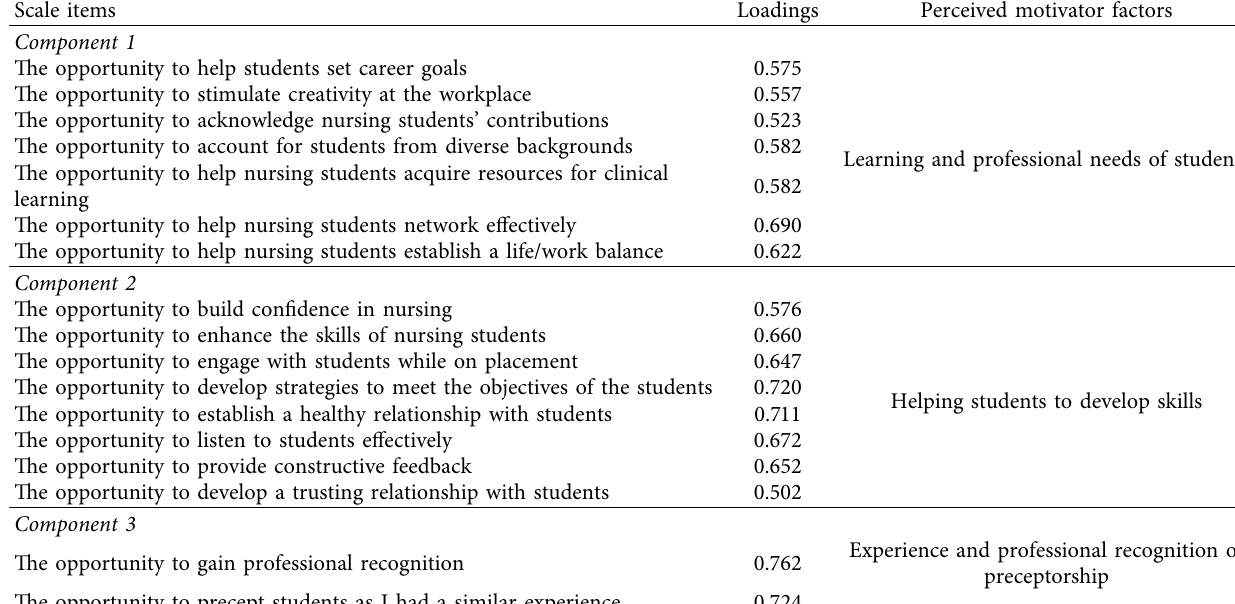
Table 3: Exploratory factor analysis on the perceived motivators to precepting nursing students.